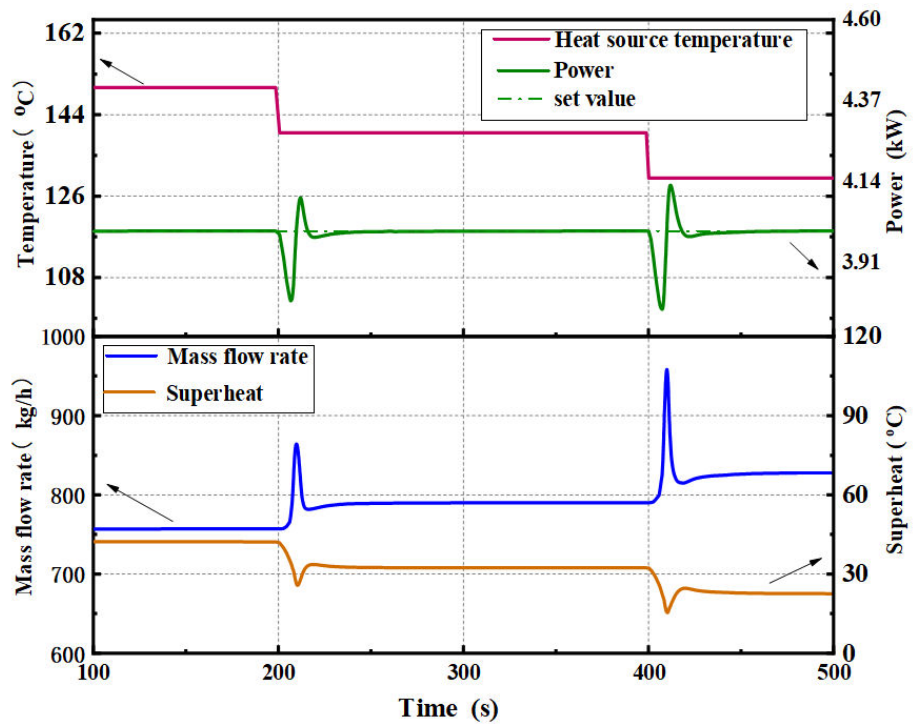
Figure 13. Dynamic response of key operating parameters under the CPL